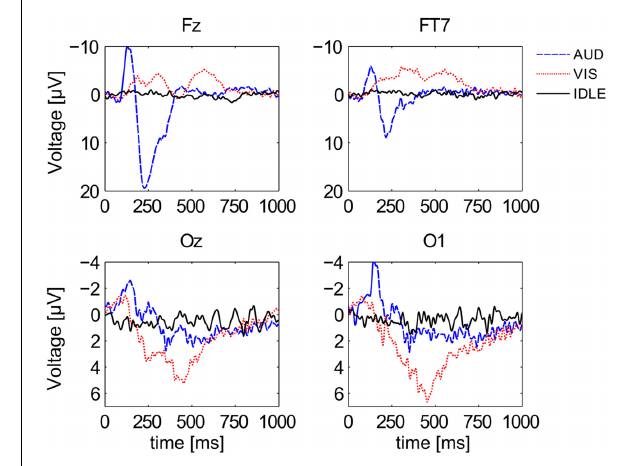
FIGURE 4 | Grand averaged HRFs of HbO (top) and HbR (bottom) for visual (left) and auditory (right) channels. Depicted are averages for the classes AUD (blue), VIS (red), and IDLE (black). The area shaded in gray marks the average duration of a stimulus presentation.